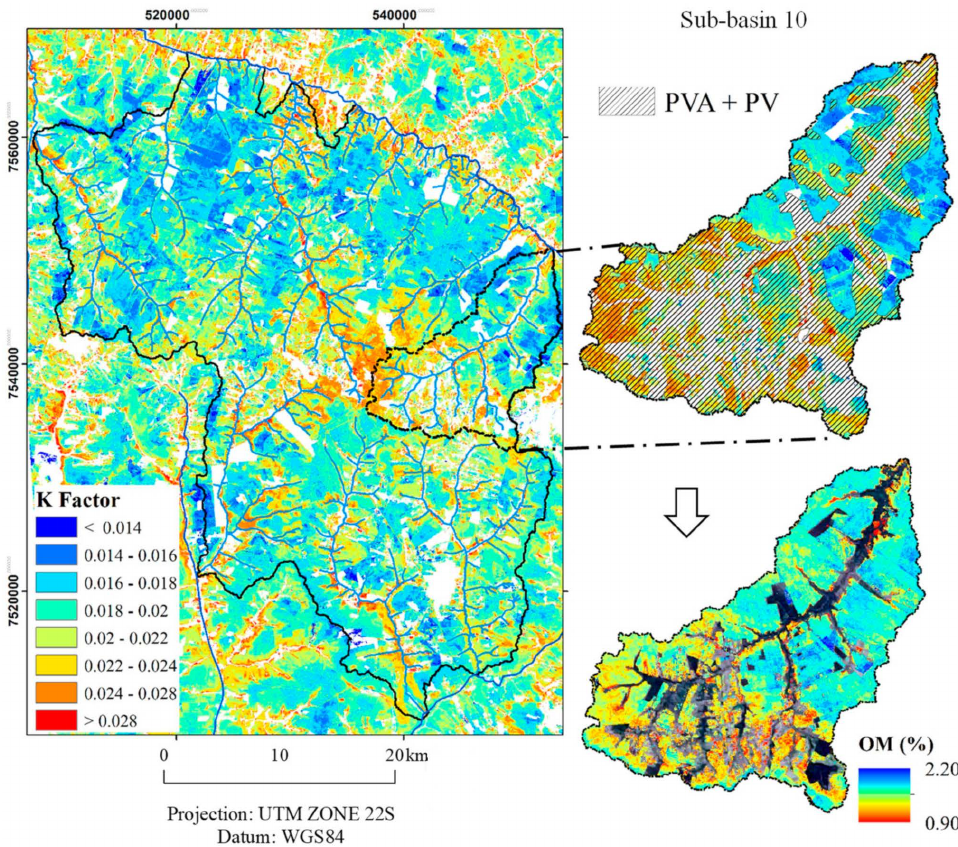
Figure 7. Soil K-Factor derived from satellite base estimation contrasting organic matter values at sub-basin 10.